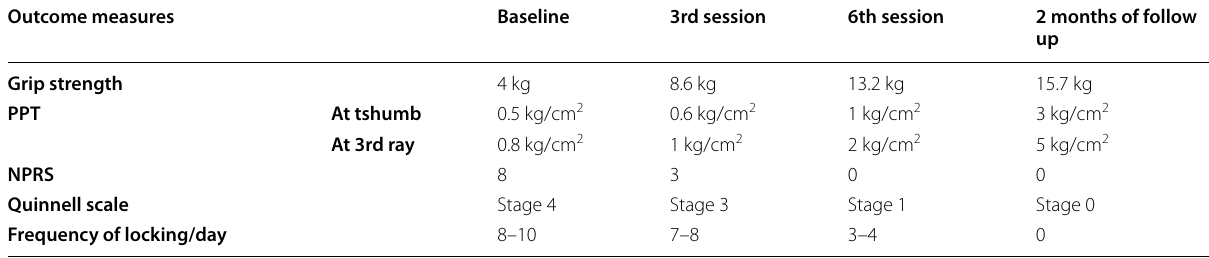
Table 1 Outcome measures Outcome measures Baseline